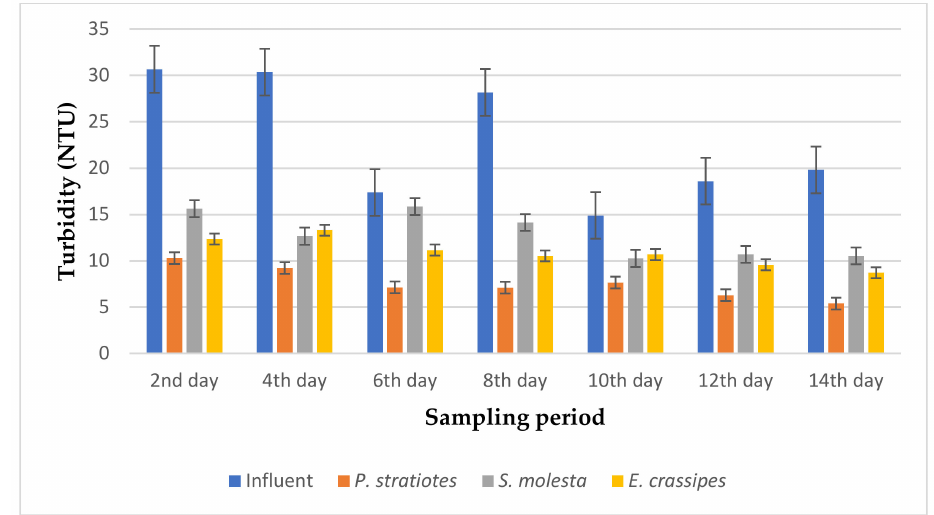
Figure 3. Bar plot of the average turbidity vs. the sampling period with a 6 h retention time.